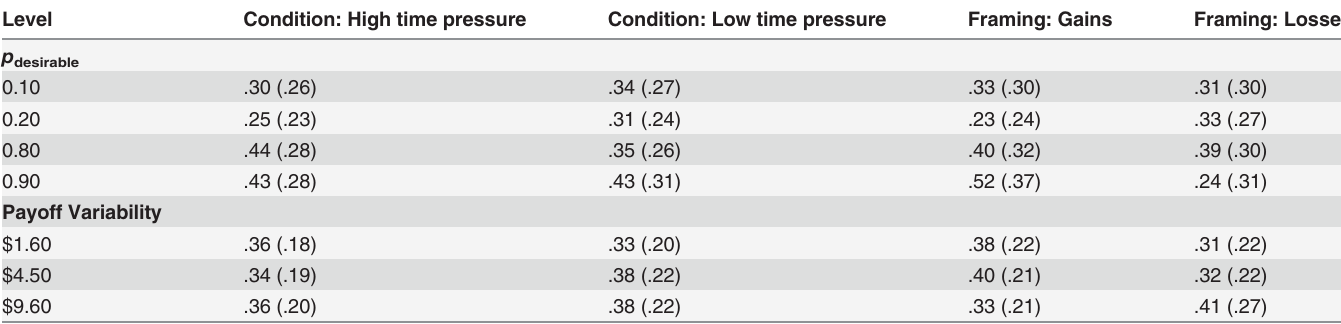
Table 4. Experiment 1 — Proportion of risky choices taken for differing levels of p desirable and payoff